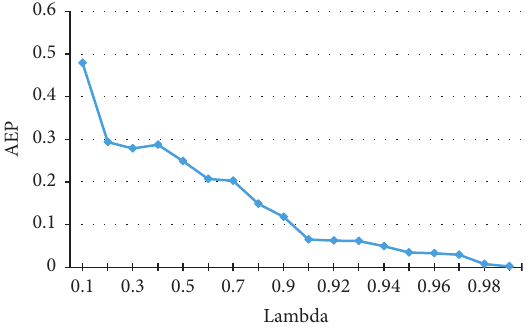
Figure 3: The AEP of different λ values.